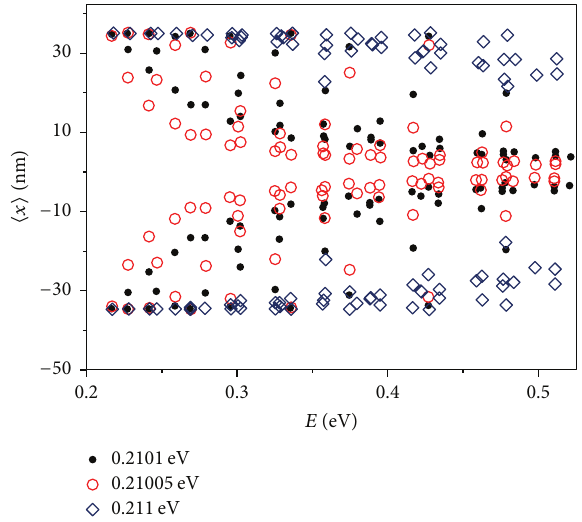
Figure 8: Single electron average coordinate ⟨𝑥⟩ along the energy spectrum for asymmetric DQW under different confinement poten- tials 𝑉 𝑠 in left QW (shown in the inset). The potential in right QW is not changed ( 𝑉 𝑠 = 0.21 eV). The interdot distance is kept constant and equal to 4